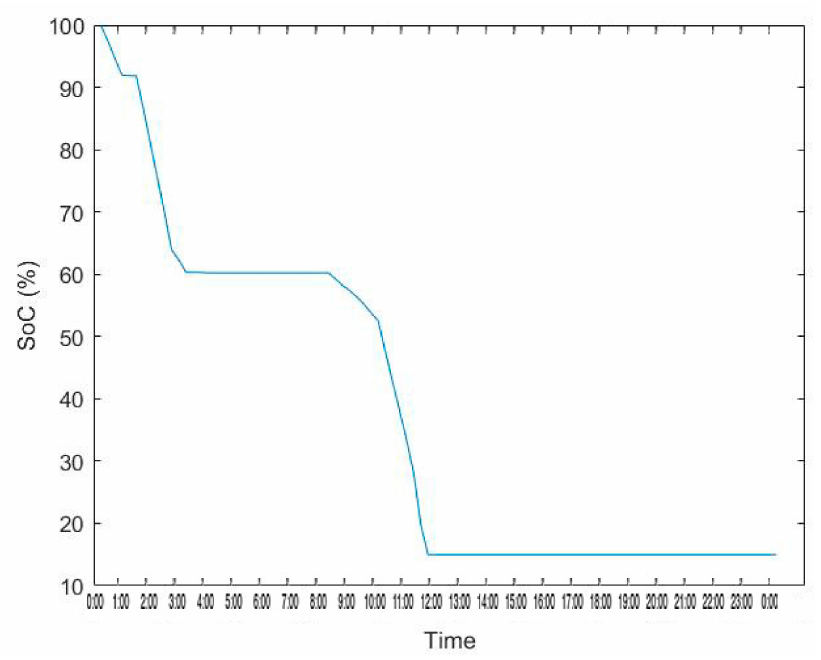
Figure 25. State of charge of Street Battery in